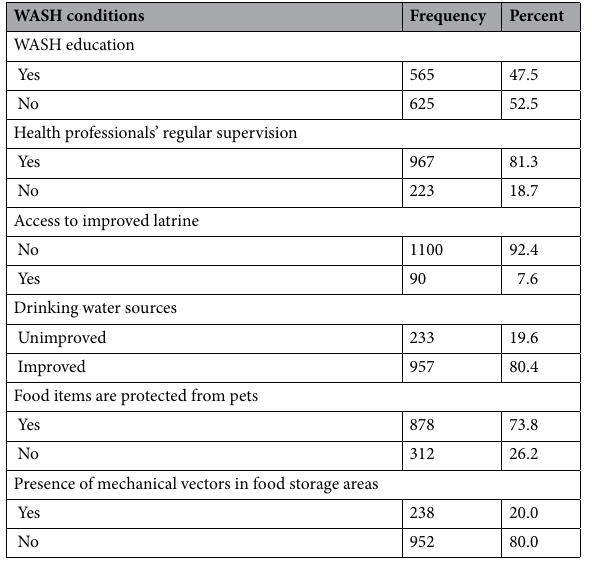
Table 2. Water, sanitation and hygiene conditions of households (n = 1190) in a rural setting of northwest Ethiopia, May 2016.